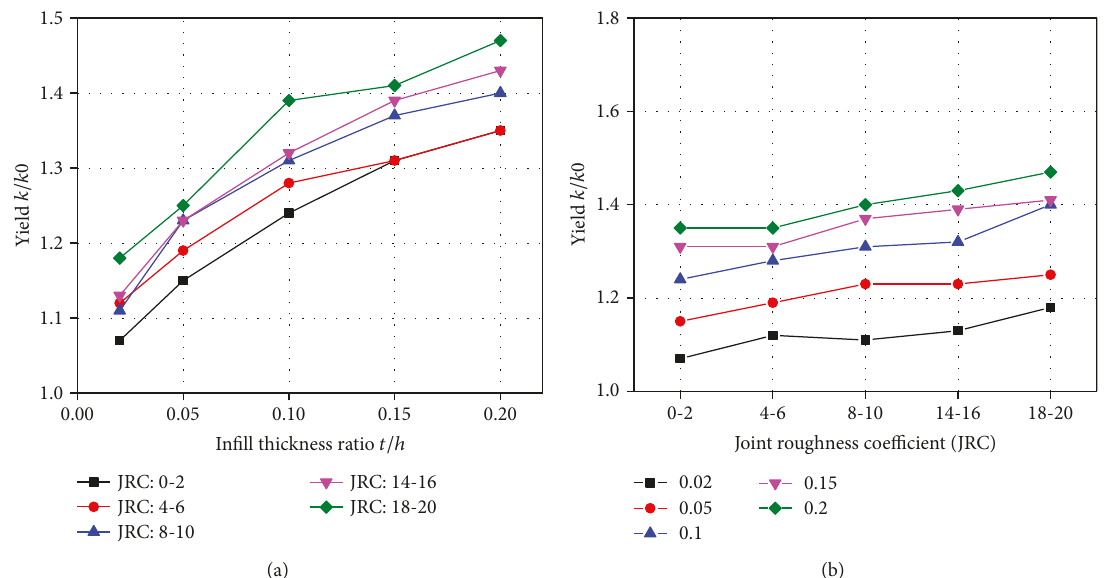
Figure 8: E ff ects of the (a) thickness ratio ( t/h ) and (b) joint roughness coe ffi cient (JRC) on permeability